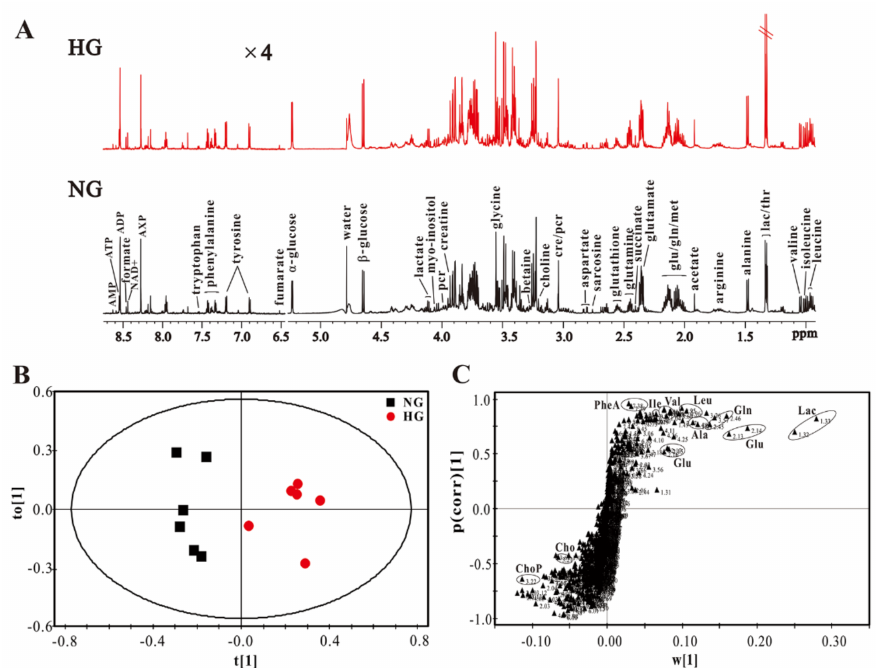
Figure 3. NMR-based H9c2 cell metabolomic analysis: ( A ) typical 600 MHz 1 H-NMR spectra obtained from the intracellular extracts under high glucose (HG, 33 mM) and normal glucose (NG, 5.5 mM) conditions; OPLS-DA scores plot ( B ) and its corresponding S-plot ( C ) based on the metabolic profiles of H9c2 cells. Metabolite: ChoP, choline phosphate; Cho, choline; PheA, phenylalanine; Glu, glutamate; Ile, isoleucine; Val, valine; Leu, leucine; Gln, glutamine; Lac,